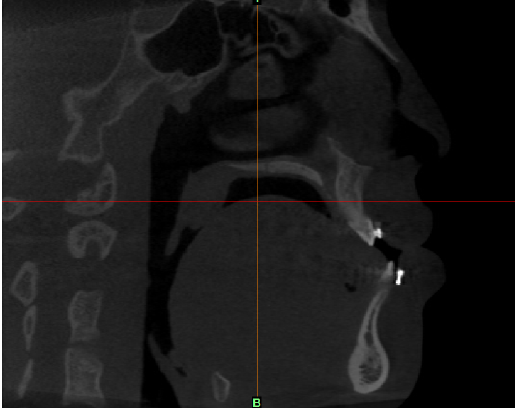
Figure 2. Example of CT-scan sagittal view of pretreatment of OSA. Adapted with permission from Ref. [28] . 2015, Butterfield.